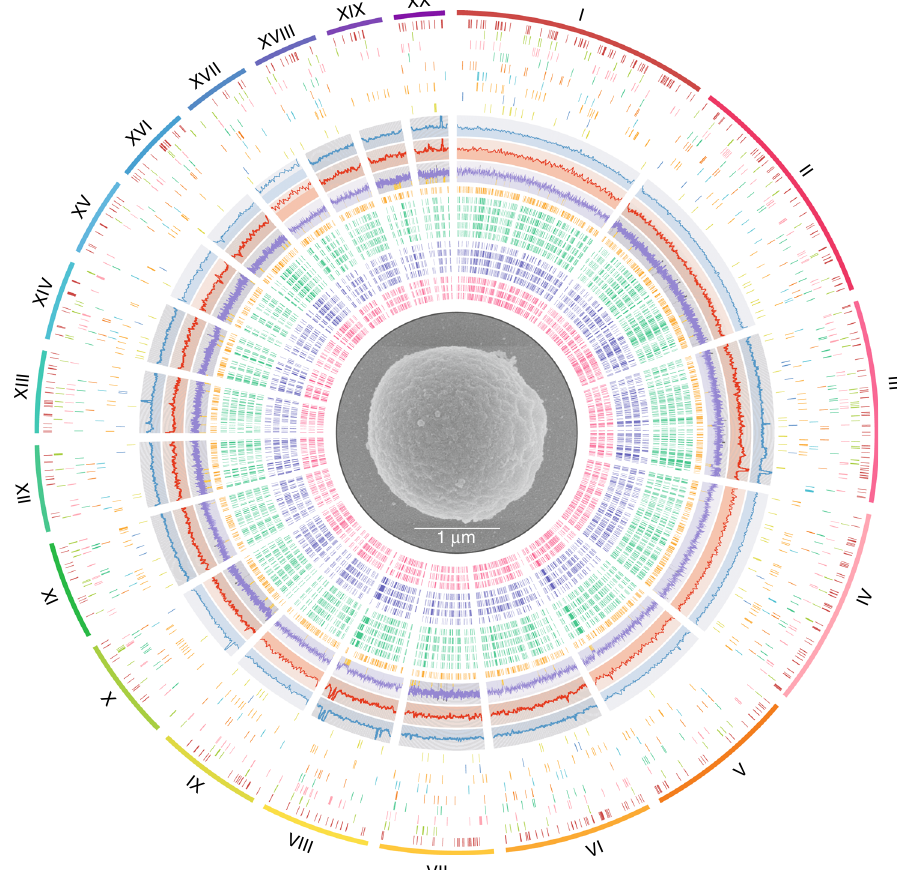
Fig. 2 Physical map of the Chloropicon genome. Center. Scanning transmission electron microscopic image of this alga (provided by W. Eikrem and T. Pollina, University of Oslo). Outer ring. The 20 chromosomes were labeled from I to XX (largest to smallest; magenta to purple). Inner rings 2 – 10. Distribution of Chloropicon genes across the KEGG metabolic pathways. From outside to inside; (2) genetic information processing, (3) environmental information processing, (4) cellular processes, (5) carbohydrate metabolism, (6) energy metabolism, (7) lipid metabolism, (8) amino acid, and nucleotide metabolism, (9) glycan biosynthesis and metabolism, (10) cofactors, vitamins, terpenoids, and polyketides metabolism. Inner ring 11. Illumina (paired-end + mate pair) sequencing depth below/above average (370×) is colored in blue/light blue ( y -axis min-max: 100 – 700). Inner ring 12. PacBio sequencing depth below/above average (73×) is colored in red/light red ( y -axis min-max: 0 – 150). Inner ring 13. GC content of Chloropicon chromosomes. Background is colored in purple/light purple for values below/above average (57.5 %) ( y -axis min-max: 37.5 – 77.5). Regions displaying GC content lower than 48% or higher than 70% are highlighted underneath by gold and gray lines, respectively. Inner rings 14 – 26. Genes shared between Chloropicon and other green algal genomes; (14) K. fl accidum (gold), (15 – 19) O. tauri , O. lucimarinus , M. pusilla , M. commoda and B. prasinos (green), [20 – 23] Helicosporidium sp., C.